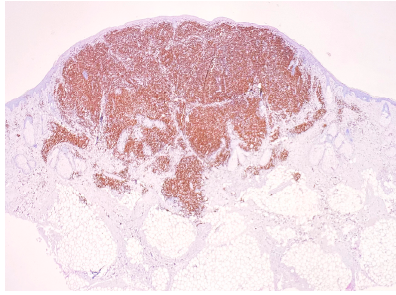
Figure 5. CD3 staining. Magnification 20×. CD4: positive in most infiltrate lymphocytes (T helper lymphocytes) (Figure 6). CD4+ T helper cells represent an essential part of the human immune system. They are often